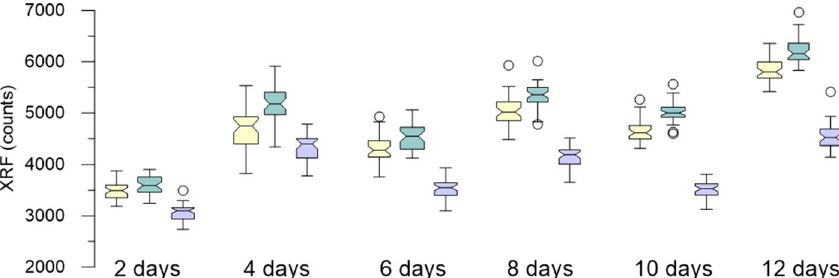
Figure 5. Examples of the effect of different adsorption times in a 50 ppm solution over two to twelve days. Yellow = Ni, Turquois = Zn, Powder Blue = Pb.